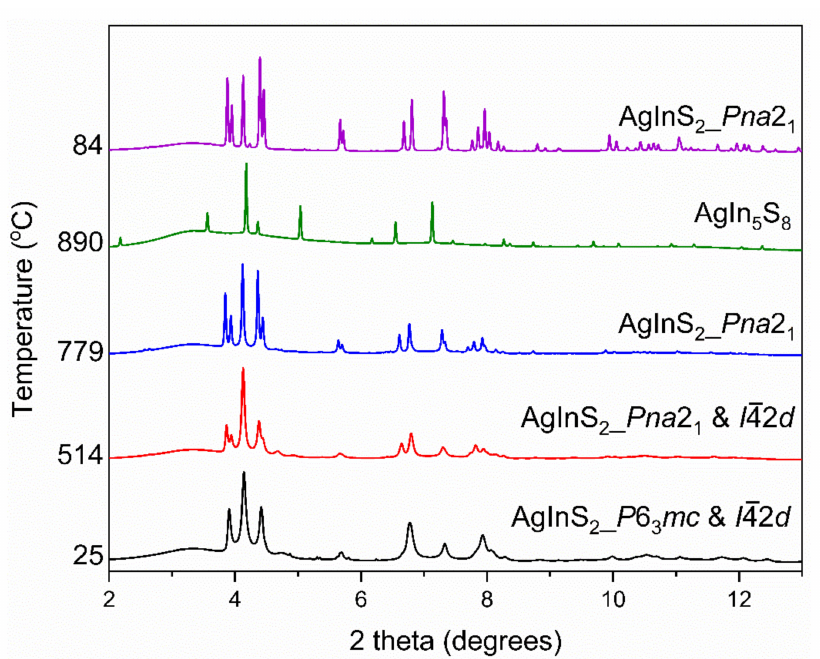
Figure 8. HT–PXRD data of 0.5 mmol the 2-step DES-synthesized AgInS 2 upon heating and